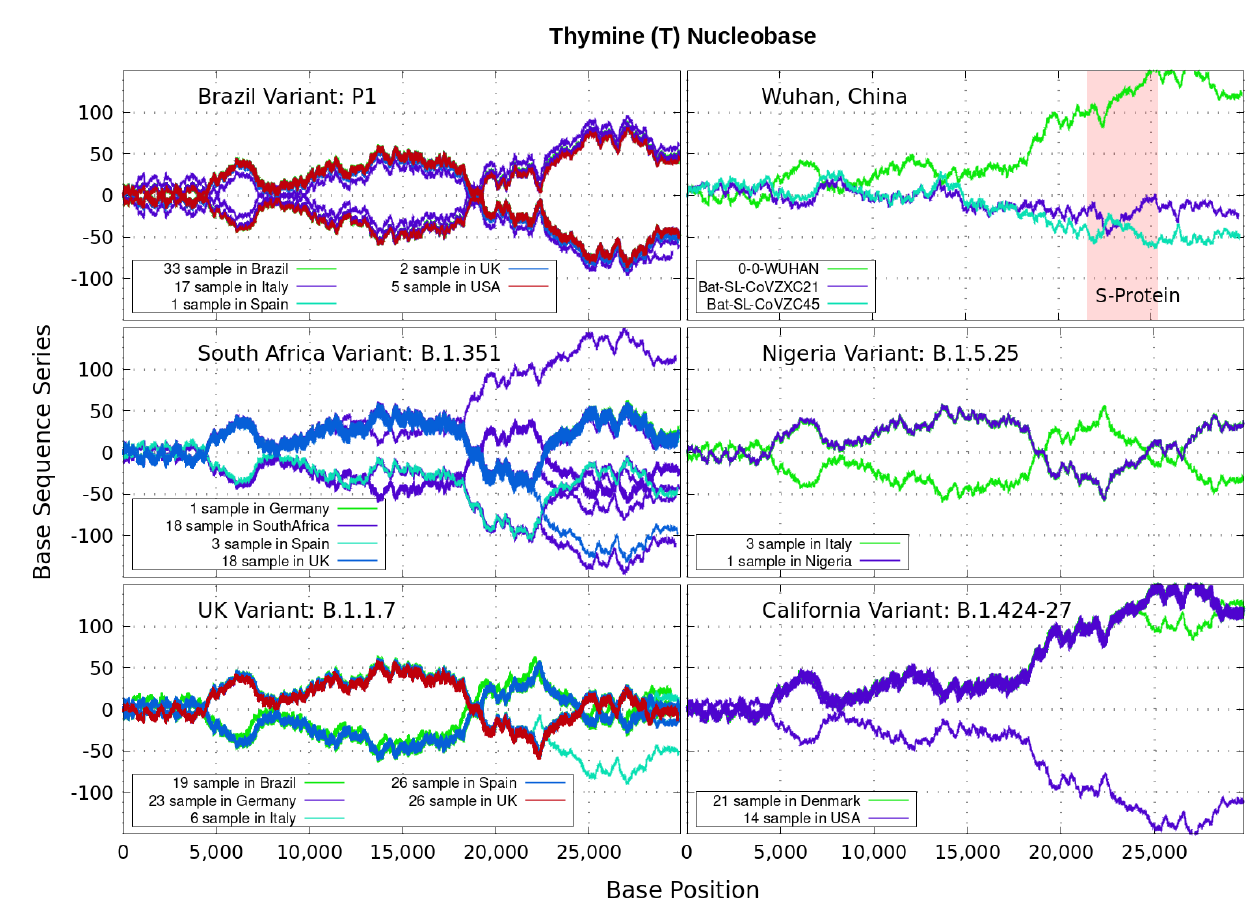
Figure 4. Variant imprints displayed by the nucleotide base: Thymine. Note : The coronavirus genome uses RNA for encoding proteins, not DNA. The nucleotide base T is related to ( U ) racil in the nucleic acid RNA via three nucleotide bases, or mRNA codon. This allows to correlate symbols used for nucleic acids (polymers of nucleotides) to that of proteins (polymers of amino